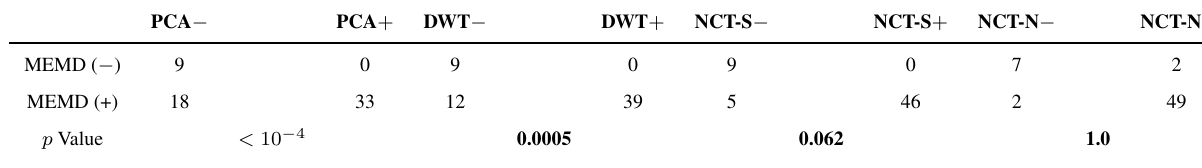
Table 2. McNemar’s statistical test results for multi-exposure